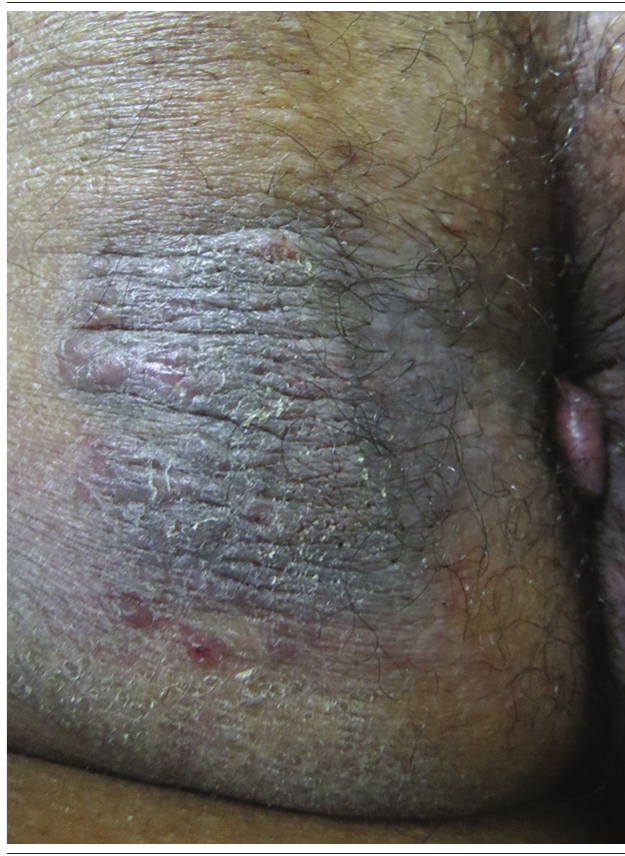
figurE 3 − Clinical aspect of patient with metastatic cutaneous Crohn’s disease: grayish infiltrated plate on the left buttock, not adjacent to the anus